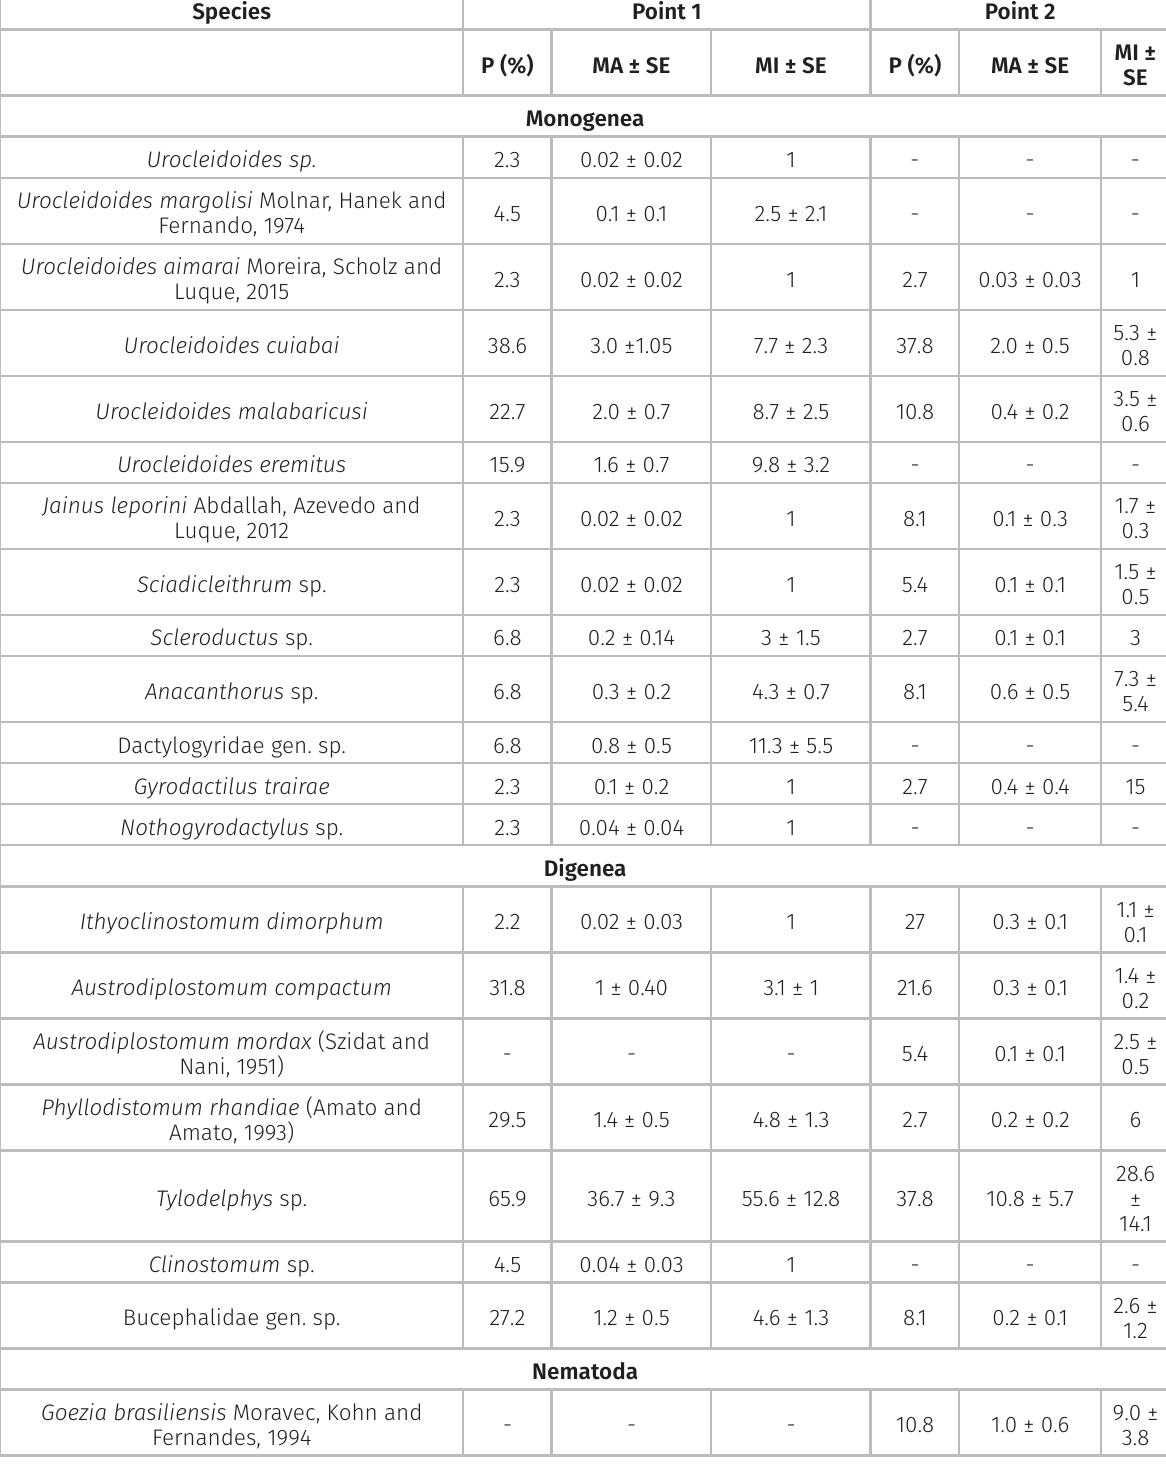
Table II. Prevalence (P), mean abundance (MA) and mean intensity (MI) of parasites of Hoplias malabaricus (Bloch, 1794) captured in the Batalha River, São Paulo State, Brazil, between February 2014 and June 2016.